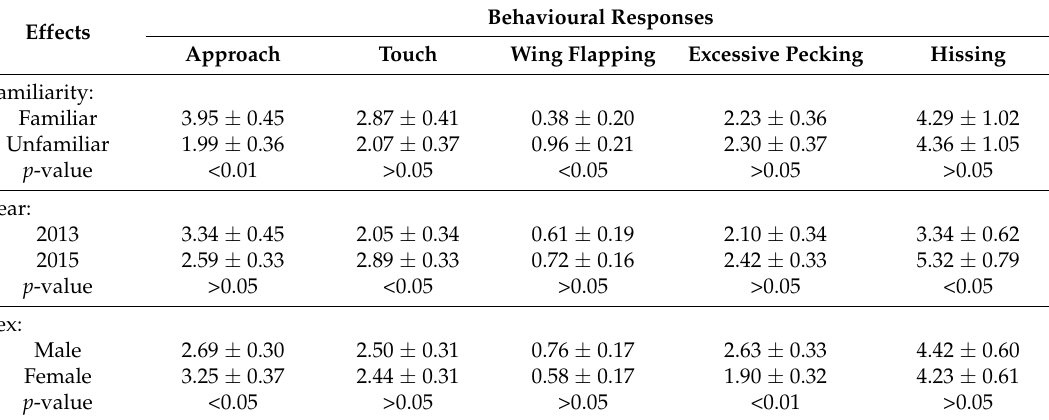
Table 1. Predicted least square mean estimates ( ± SE; derived from back transformation of the logit function) from reactivity tests of handler familiarity, experimental year, and sex on ostrich behavioural activities as directed towards the human